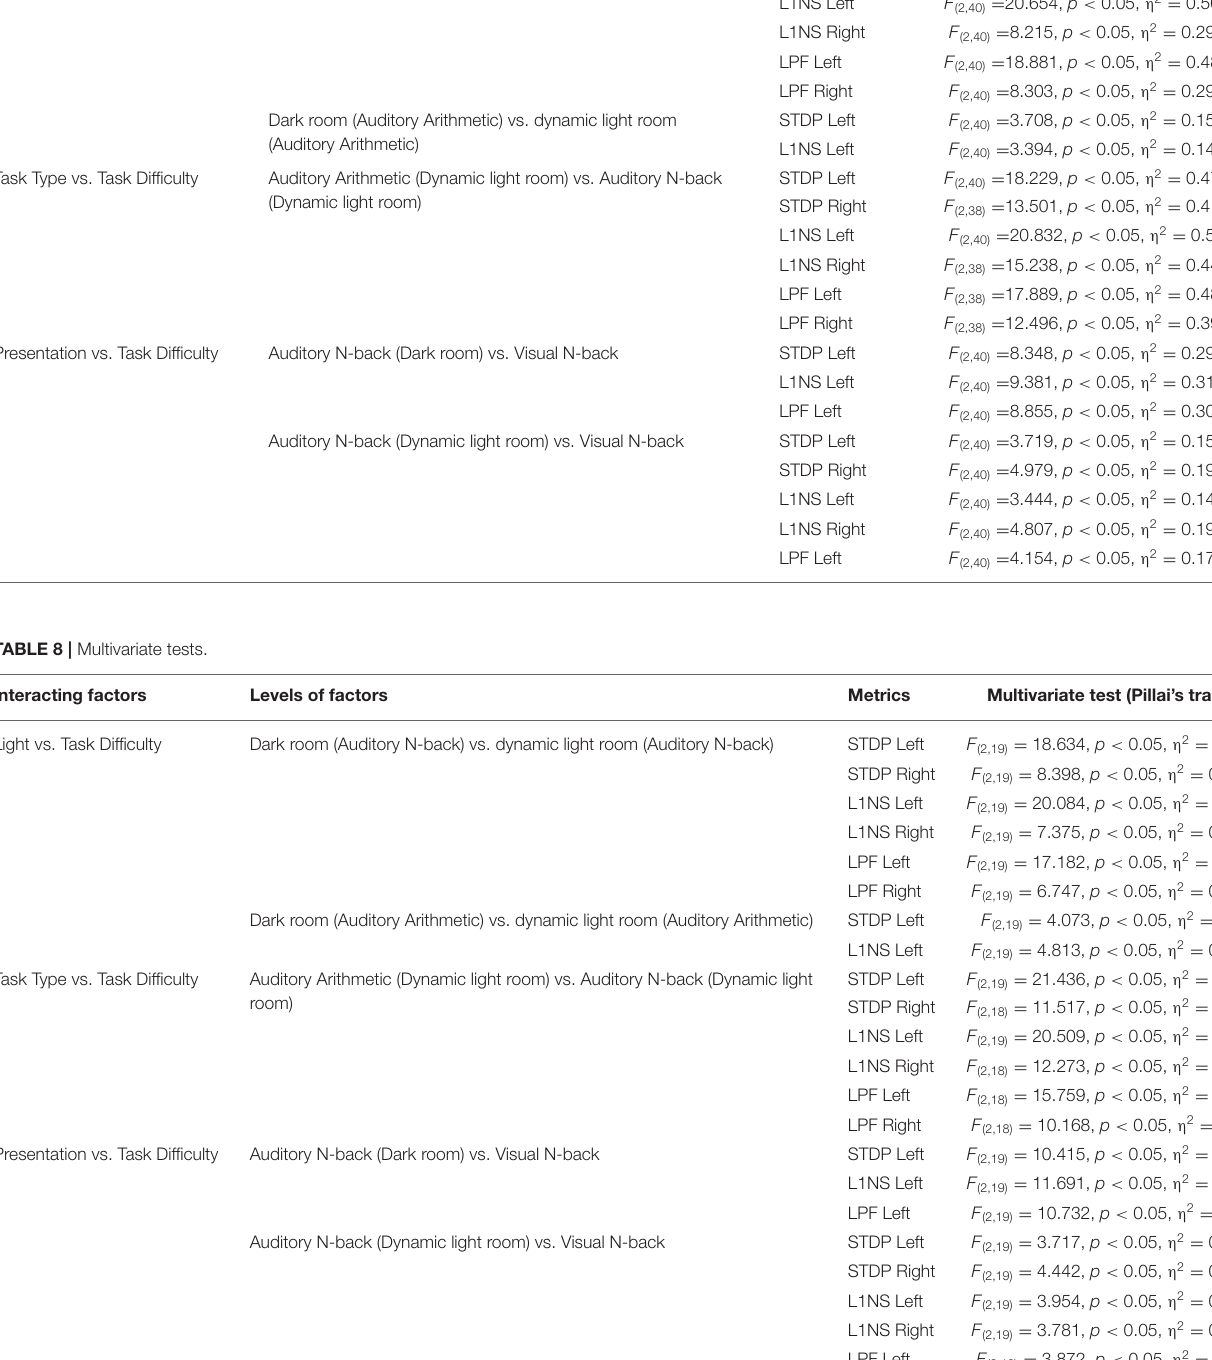
Light vs. Task Difficulty